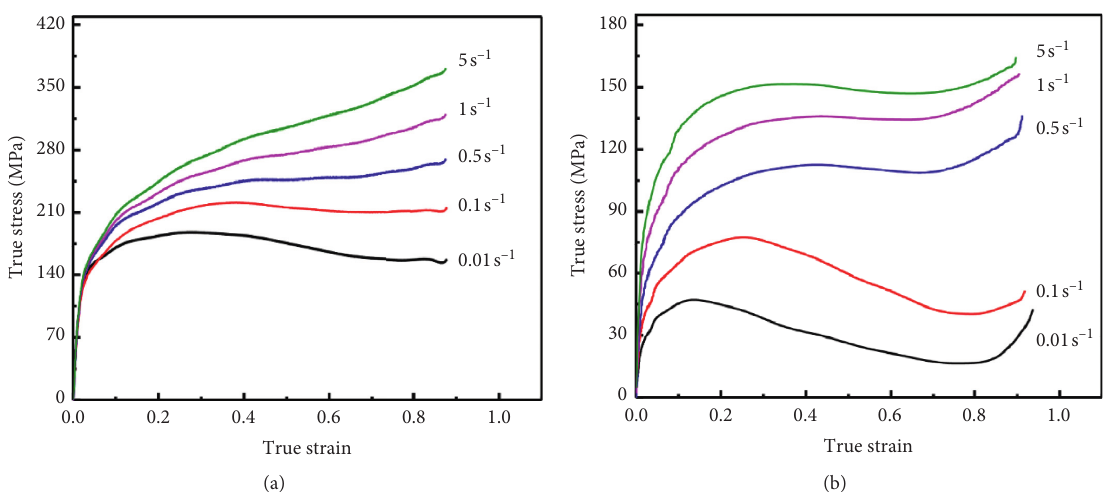
Figure 3: Influences of strain rates on flow stress at 850 ° C (a) and 1050 ° C